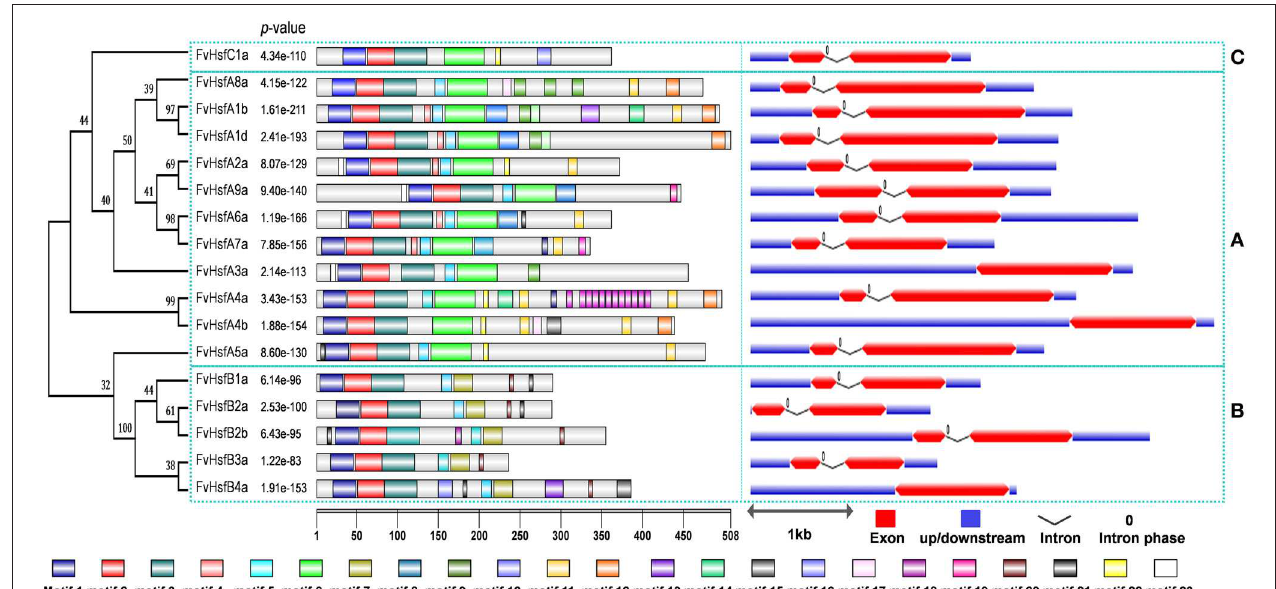
FIGURE 2 | Structural analysis of strawberry Hsf genes. The protein domains of the strawberry Hsf genes are shown on the left and are denoted by rectangles with different colors. The exon-intron organization is shown on the right, with exons and introns represented by red wedges and black lines, respectively, and untranslated regions (UTRs) indicated by blue boxes. The number 0 represents the intron phase. The exon size can be estimated using the scale at the bottom of the diagram, while all of the introns were set to same length. The blue dashed rectangles are used to cluster the genes into the A, B, and C